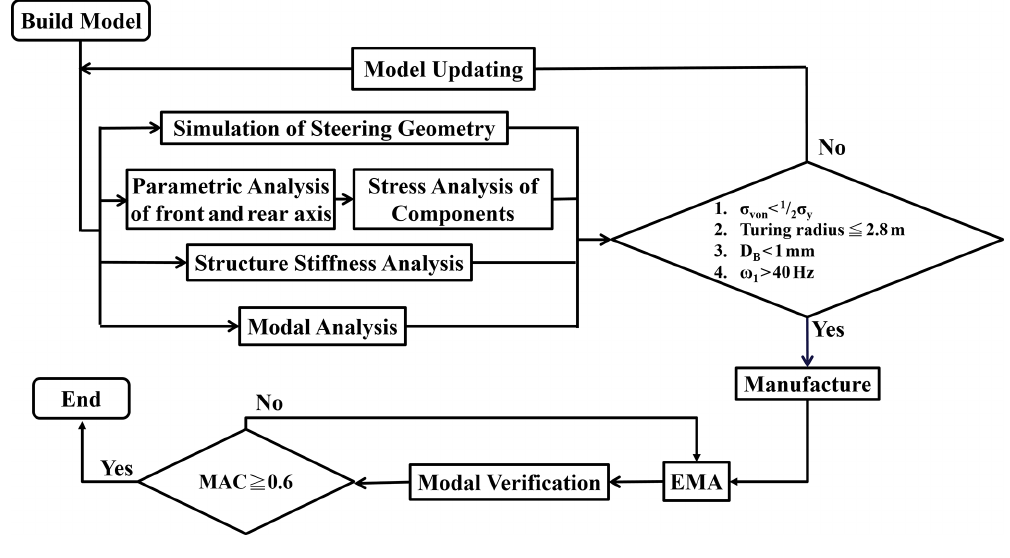
Figure 1. Flow chart of the research method.